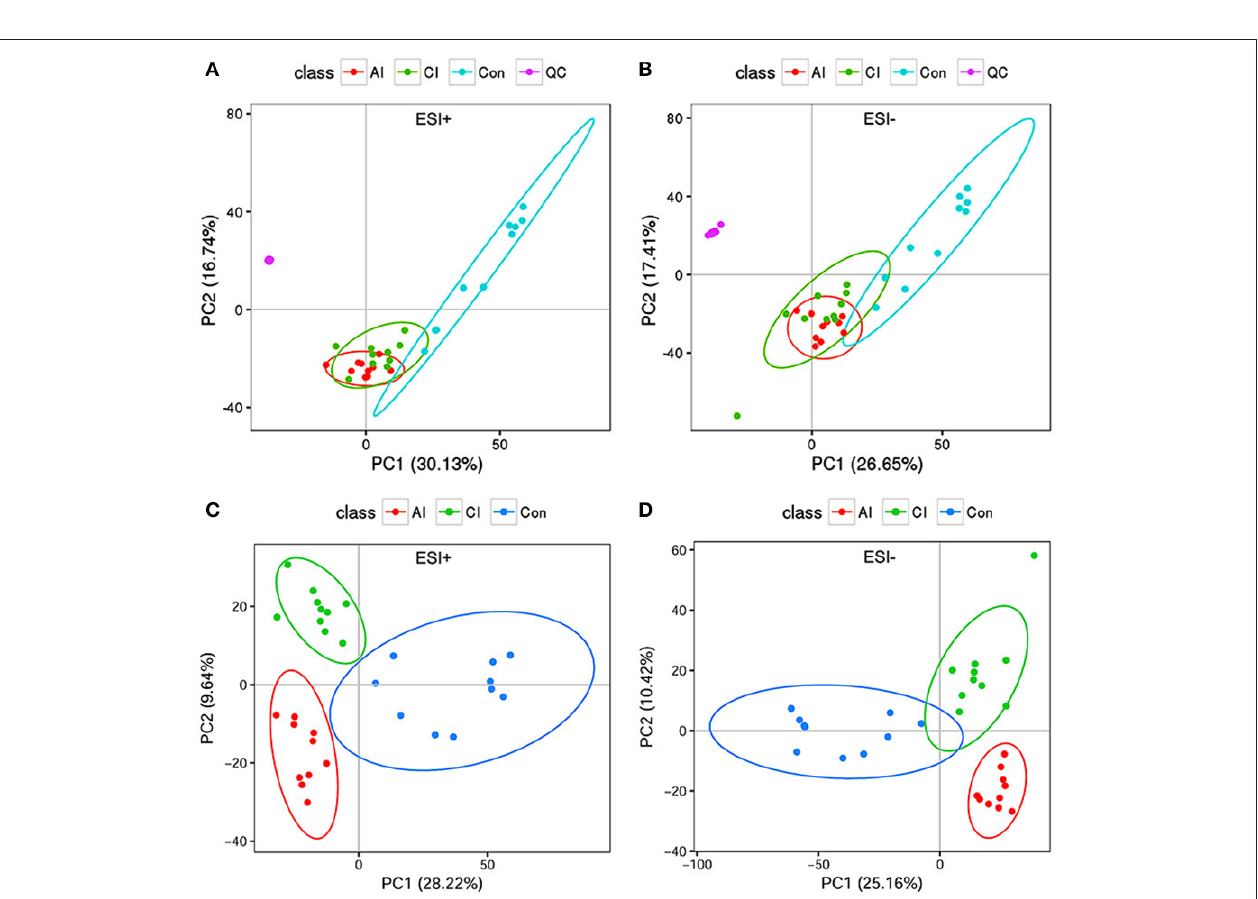
FIGURE 2 | Multivariate statistical analysis of the data. (A) PCA scores plot of mice livers, including acutely infected (AI), chronically infected (CI) and uninfected control (Con) compared to quality control (QC) samples in the positive ion mode (ESI + ). (B) PCA scores plot of mice livers in the negative ion mode (ESI–). Clear separation was detected among the different mice groups and in relation to QC samples. (C) Two dimensional PLS-DA score plots of the acutely infected (AI), chronically infected (CI) and uninfected control (Con) in the positive ion mode (ESI + ). (D) Two dimensional PLS-DA score plots of AI, CI and Con in the negative ion mode (ESI–). Each dot represents one liver sample, projected onto first (horizontal axis) and second (vertical axis) PLS-DA variables. Mice groups are shown in different colors. The black ellipse indicates the 95% confidence interval.